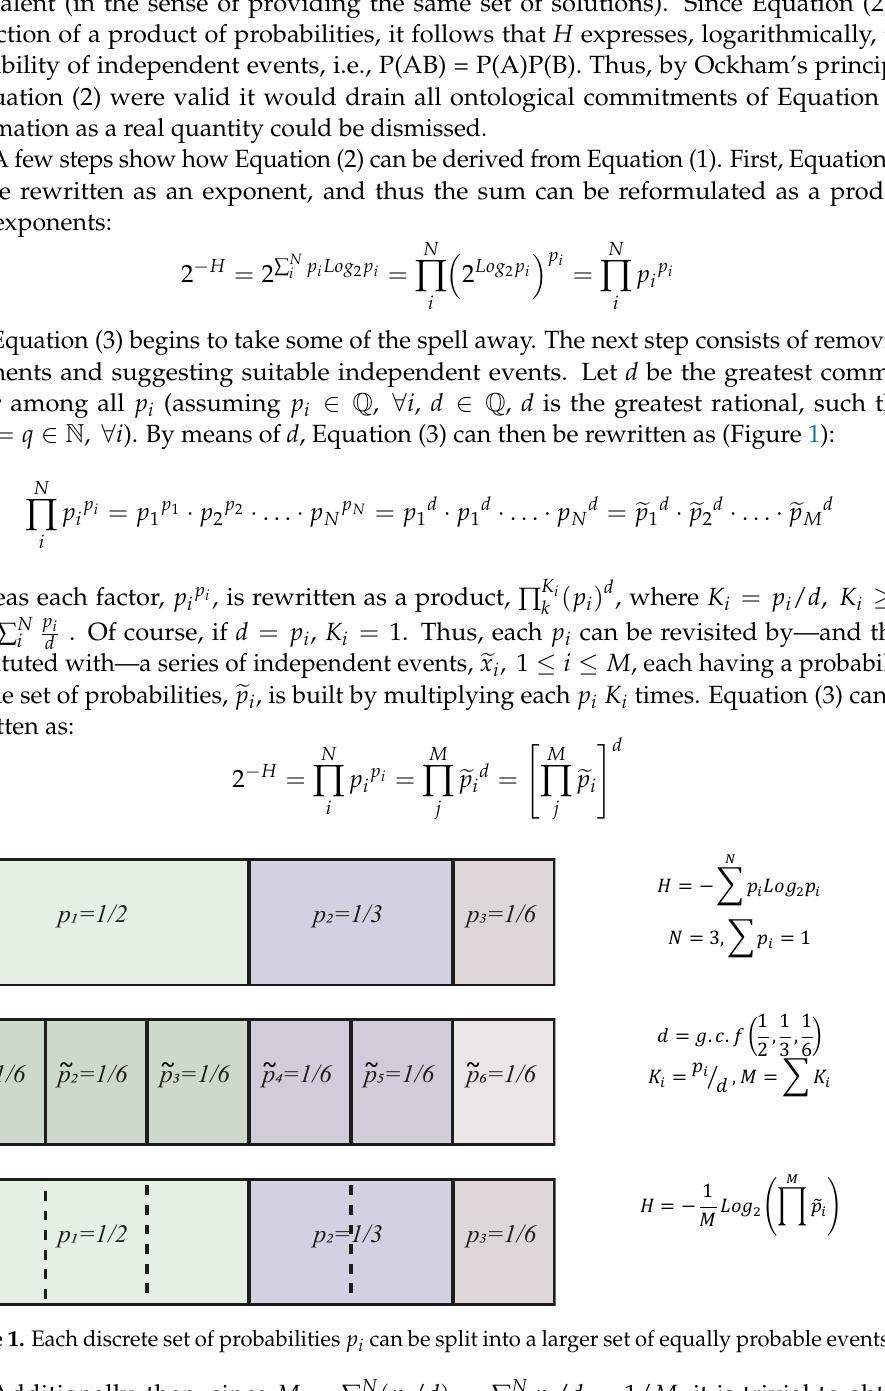
( a ) ( b ) Figure 2. ( a ) X, such that 𝑝 1 = 1 2 , 𝑝 2 = 1 2 , since ∏ 𝑝̃ 𝑖 𝑀 = 𝑝̃ 1 𝑝̃ 2 = 1 4 ; ( b ) X, such that 𝑝 1 = 3 4 ,𝑝 2 = 1 4 , since ∏ 𝑝̃ 𝑖𝑀 = 𝑝̃ 1 𝑝̃ 2 = 3 16 . Consider a handful of numerical examples. First, suppose having two outcomes with probabilities { 1 3 , 1 2 } , then 𝑑 = 1 6 , since 1 6 is their greatest common factor, i.e., d is a rational number by which 1 3 / 1 6 = 2 , 1 2 / 1 6 = 3 . In fact, ( 1 3 ) 1 3 ⋅ ( 1 3 ) 1 3 = ( 1 3 ) 1 6 ( 1 3 ) 1 6 ⋅ ( 1 2 ) 1 6 ( 1 2 ) 1 6 ( 1 2 ) 1 6 Second, suppose having three outcomes, 𝑥 1 , 𝑥 2 , 𝑥 3 , with probabilities { 1 6 , 1 3 , 1 2 } , N = 3. Their greatest common factor common is d = ⅙ . By multiplying all elements according to the ratio 𝐾 𝑖 = 𝑝 𝑖 𝑑⁄ , a set, {𝑥̃ 𝑗 }, 𝑀 = 6 , where each element has a probability of 𝑑 = 1 6 = 1 𝑀 , we